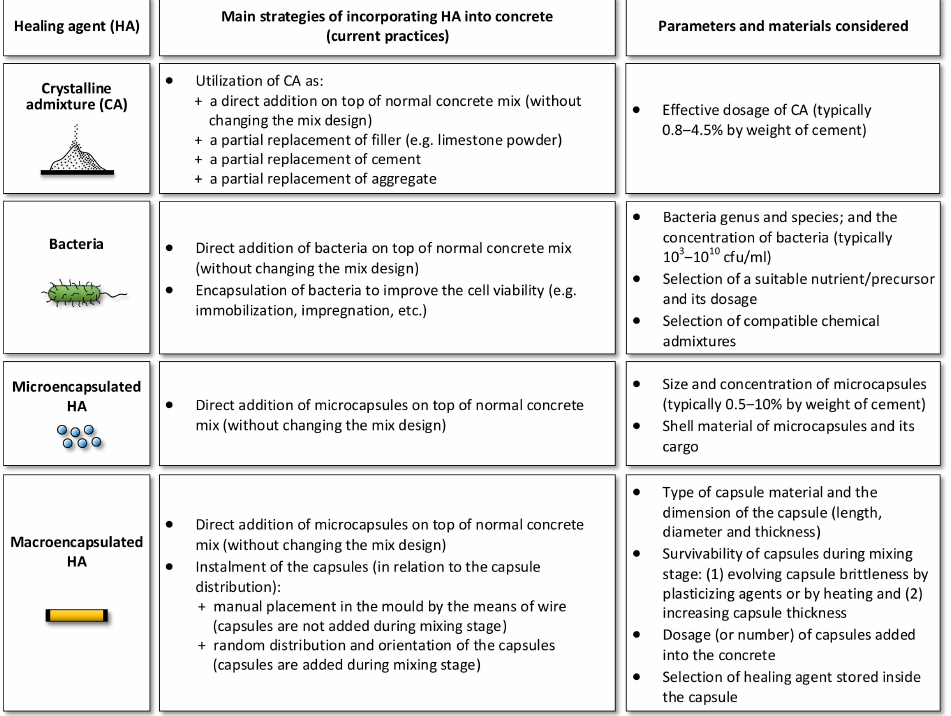
Figure 6. Main strategies to introduce healing agents in the recent application of self-healing